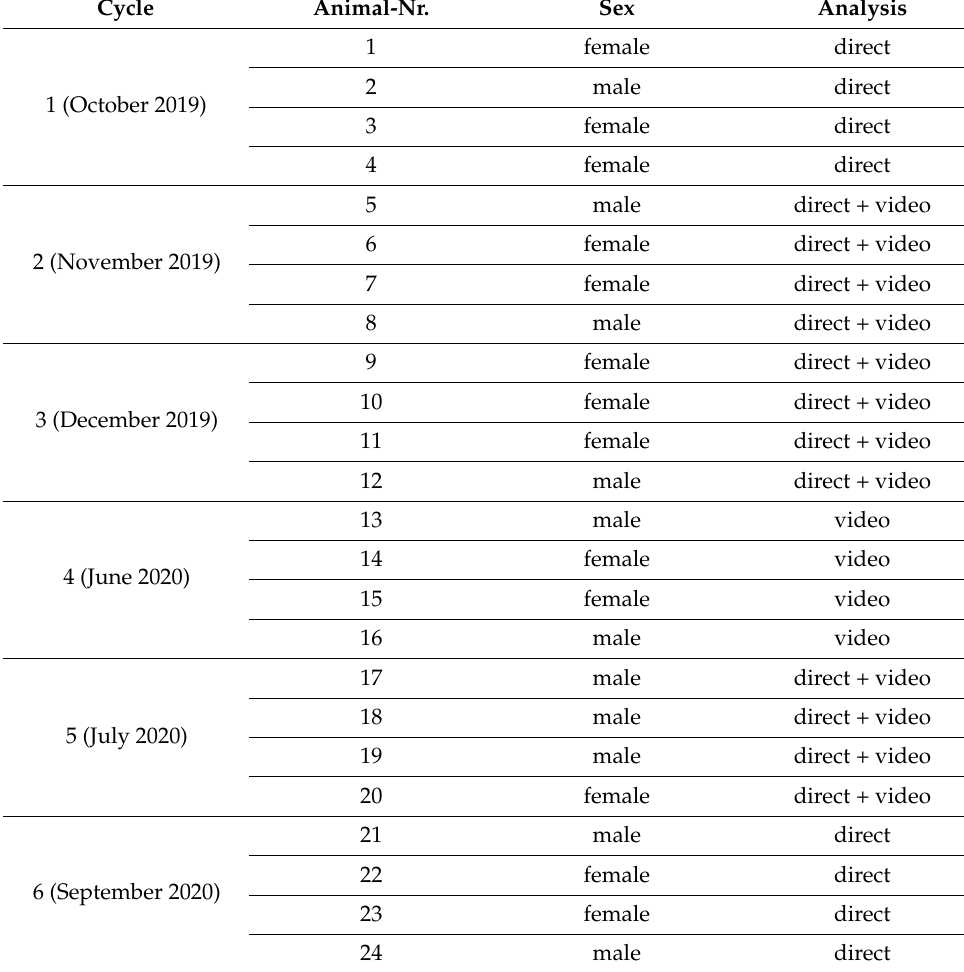
Table 2. Summary of performed and analysed experimental cycles. Cycle Animal-Nr. Sex